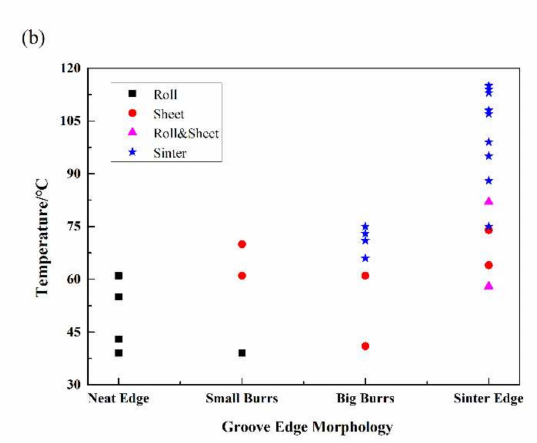
Figure 8. ( a ) surface roughness distribution with di ff erent groove edge morphology and cutting chips in various shapes; ( b ) temperature distribution with di ff erent groove edge morphology and cutting chips in various shapes. (The surface roughness and processing temperature were the results of micromilling experiments with parameters in Table 1 and measured by the infrared camera (IGA 6 Advanced, Lumasense Technologies Co., Stockholm, Sweden) and the laser scan confocal microscope (VK-X250, Keyence Co., Osaka, Japan) with a 10 × microscope